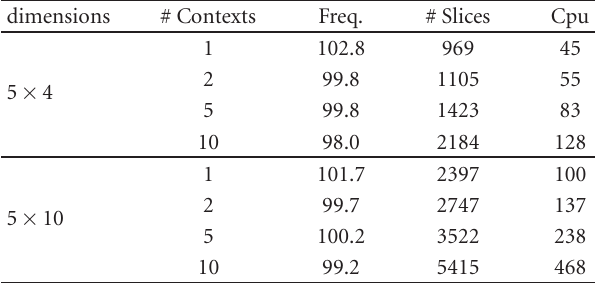
Table 3: Multiple context impact over frequency, resources, and synthesis